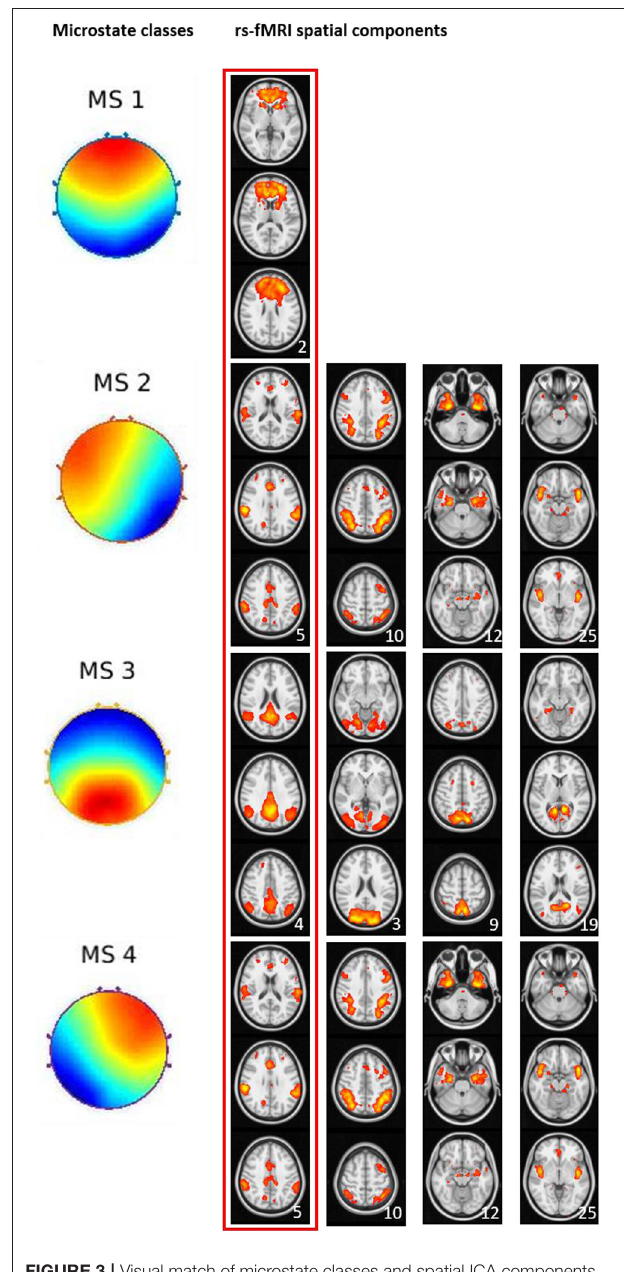
FIGURE 3 | Visual match of microstate classes and spatial ICA components from rs-fMRI. Four microstate topologies and the spatially matching rs-fMRI components. Numbers in the lower right corner of each rs-fMRI component represent the position of this component among the 30 components from ICA analysis. The red box indicates the spatial rs-fMRI components that were visually rated to most closely resemble the microstate’s topology.